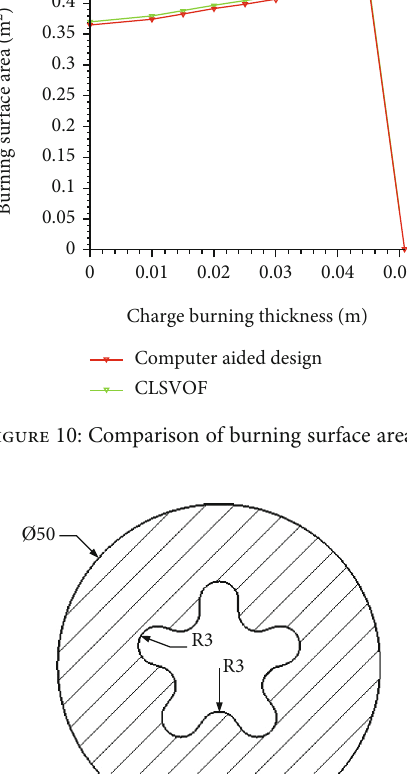
Figure 12: Comparison of burning surface area.